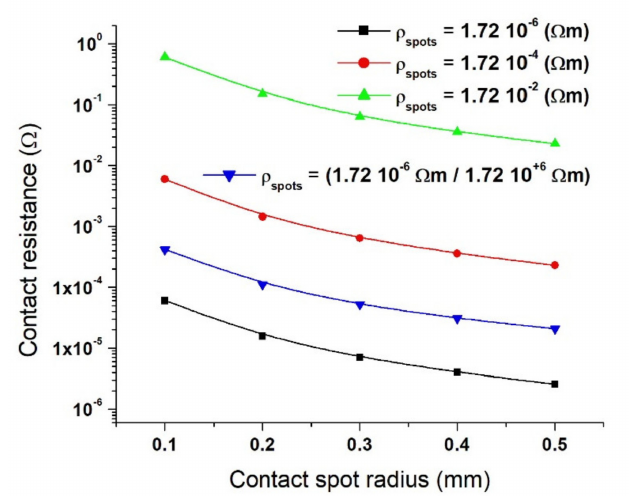
Figure 14. Contact resistance showing values for numerical model calculated for ρ Cu = 1.72 · 10 − 8 Ω · m with ρ Cs = 1.72 · 10 − 6 Ω · m; ρ Cs = 1.72 · 10 − 4 Ω · m; ρ Cs = 1.72 · 10 − 2 Ω · m, and, respectively, · 10 − 6 Ω · m/1.72 · 10 +6 Ω · ρ Cs = (1.72